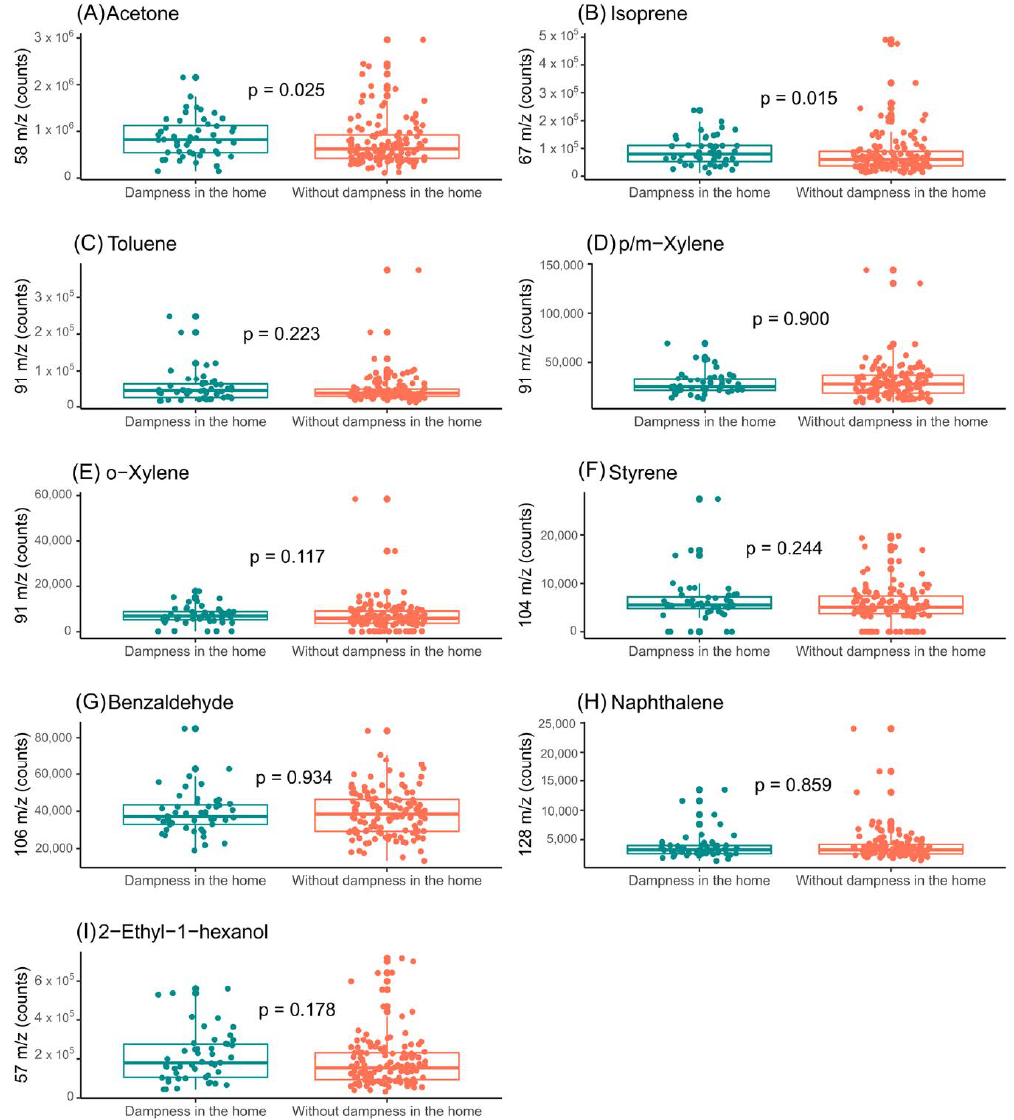
Figure 6. Assessment of influence of indoor-dampness exposure on the levels of the features selected in exhaled breath from girls. ( A ) Impact of indoor-dampness exposure on levels of acetone ( m/z = 58); ( B ) impact of indoor-dampness exposure on levels of isoprene ( m/z = 67); ( C ) impact of indoor- dampness exposure on levels of toluene ( m/z = 91); ( D ) impact of indoor-dampness exposure on levels of p/m-xylene ( m/z = 91); ( E ) impact of indoor-dampness exposure on levels of o-xylene ( m/z = 91); ( F ) impact of indoor-dampness exposure on levels of styrene ( m/z = 104); ( G ) impact of indoor- dampness exposure on levels of benzaldehyde ( m/z = 106); ( H ) impact of indoor-dampness exposure on levels of naphthalene ( m/z = 128); and ( I ) impact of indoor-dampness exposure on levels of